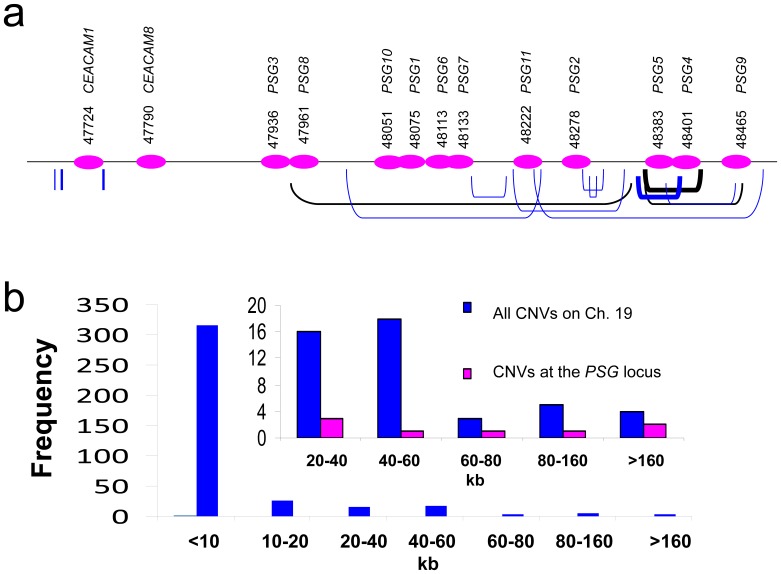
The human PSG locus exhibits frequent copy number variation (CNV).
a) Schematic representation of CNVs found at the human PSG locus on chromosome 19 (47,600–48,500 kb) based on studies using high-density probes and DNA sequencing [51], [52], [53]. CNVs that were identified in CEU (U.S. residents with northern and western European ancestry, N = 20) and YRI (Yoruba from Ibadan in African, N = 20) populations are indicated by blue brackets under the chromosome. CNVs that were identified in Asian populations (Chinese, Japanese, and Koreans; N = 30) are indicated by black brackets. CNVs that have a frequency higher than 50% are indicated by bold brackets. b) The size distribution of 387 unique chromosome-19 CNVs that have a length greater than 500 bp. The figure in the inset shows the distribution of long fragment CNVs (46 in total have a length >20 kb) found on chromosome 19 and those at the PSG locus.